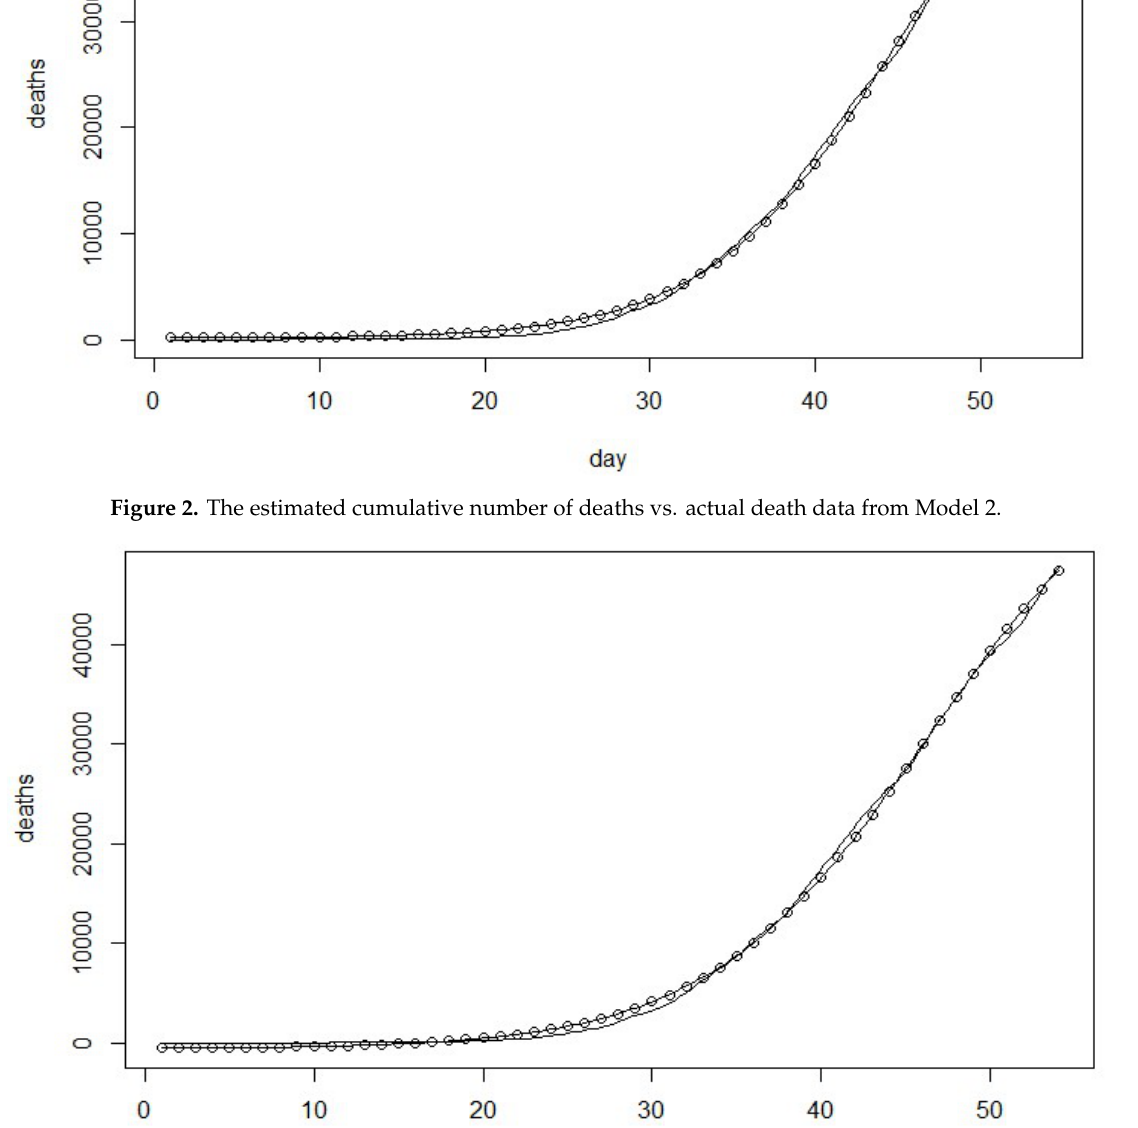
Figure 3. The estimated cumulative number of deaths vs. actual death data from Model 3.